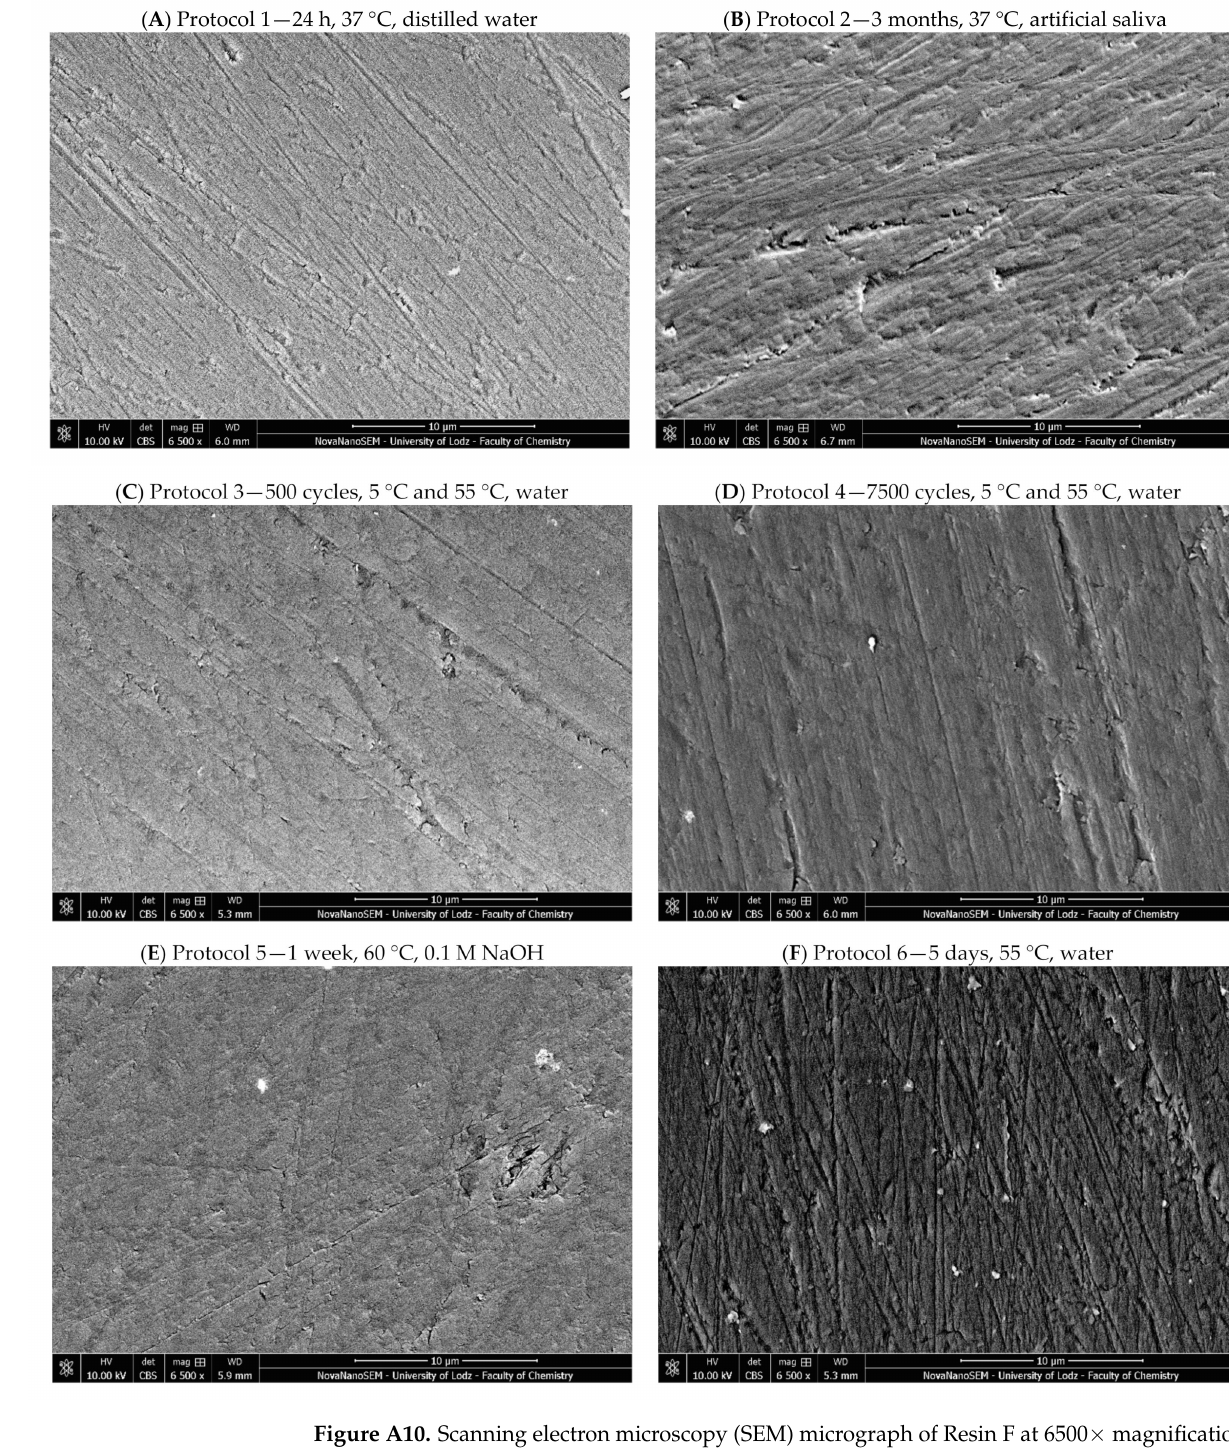
Figure A10. Scanning electron microscopy (SEM) micrograph of Resin F at 6500 × magnification after six aging protocols: ( A ) Protocol 1—24 h, 37 ◦ C, distilled water, ( B ) Protocol 2—3 months, 37 ◦ C, artificial saliva, ( C ) Protocol 3—500 cycles, 5 ◦ C and 55 ◦ C, water, ( D ) Protocol 4—7500 cycles, 5 ◦ C and 55 ◦ C, water, ( E ) Protocol 5—1 week, 60 ◦ C, 0.1 M NaOH, ( F ) Protocol 6—5 days, 55 ◦ C,